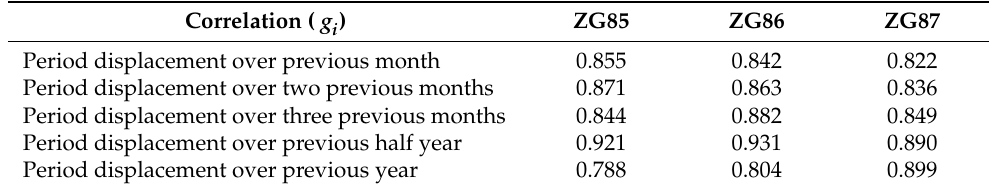
Table 1. Correlation of displacement change at different times with the PTD of each monitoring station.